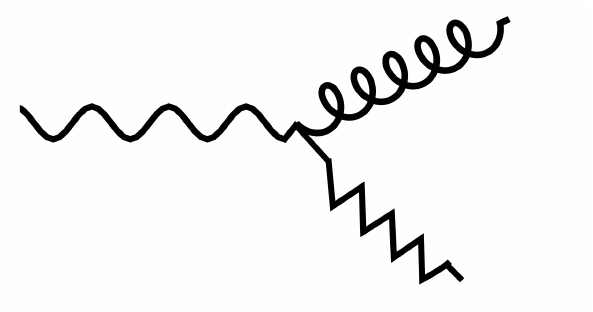
Figure 3. A schematic Feynmann diagram for the calculation of MAE. An incoming photon enables the creation of a magnon (and a phonon if magnetostuctural coupling provides the MEP), thereby driving the magnetic